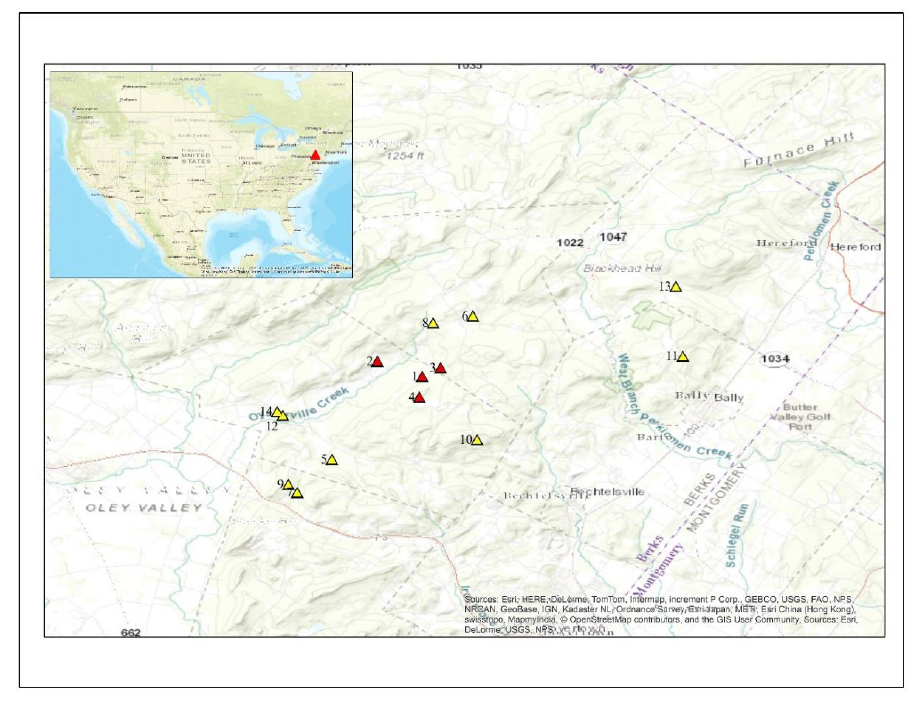
Figure 1. Plot map of Ooencyrtus kuvanae studies on Lycorma delicatula in Berks County, Pennsylvania.